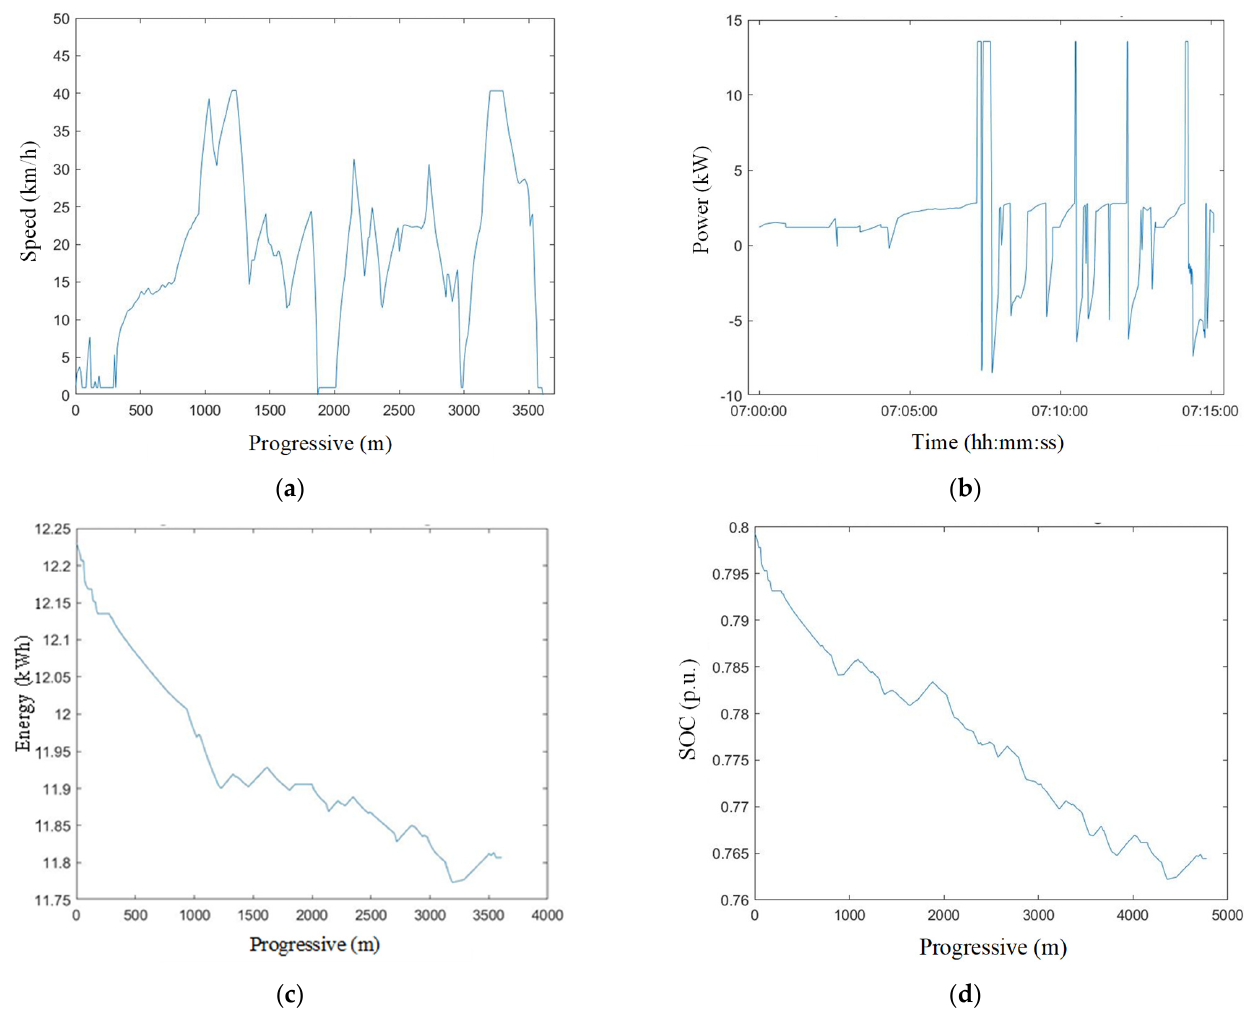
Figure 9. EV-type C performance along route 5: ( a ) Speed profile; ( b ) Power profile; ( c ) Energy profile; ( d ) SOC profile.